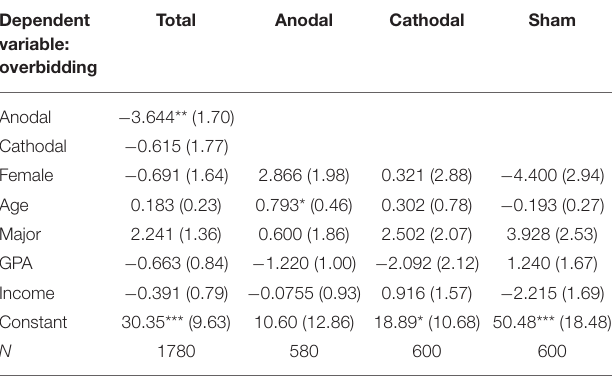
TABLE 3 | Effect of tDCS on